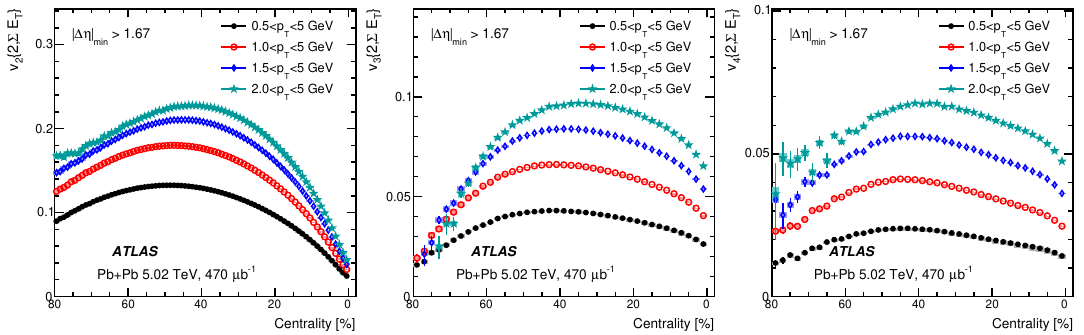
Figure 3 . The centrality dependence of v 2 f 2 ; (cid:6) E T g (left panel), v 3 f 2 ; (cid:6) E T g (middle panel) and v 4 f 2 ; (cid:6) E T g (right panel) for four p T ranges. The error bars and shaded boxes represent the statis- tical and systematic uncertainties, respectively.